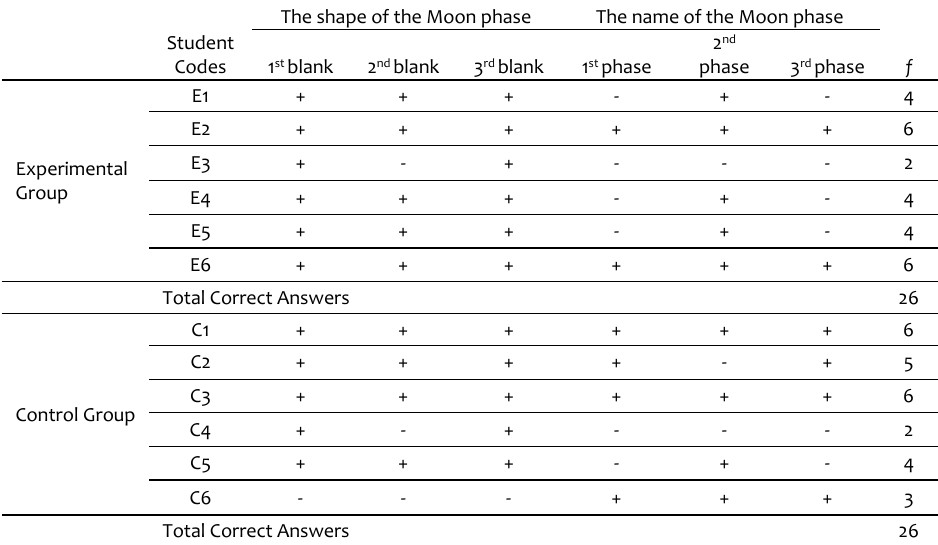
Table 10. Data on the interviewed students’ skills to draw the phases of the Moon from the three-dimensional model Student